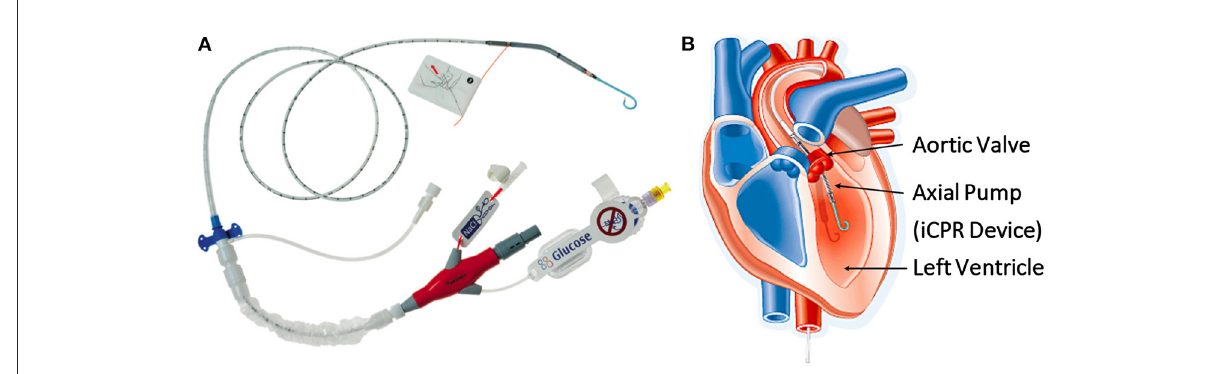
FIGURE1 (A) The Impella, a minimally invasive, catheter-based circulatory support device (Abiomed, Danvers, MA). (B) Diagram showing the anatomical positioning of the Impella across the aortic valve. (iCPR-intravascular cardiopulmonary resuscitation). ©